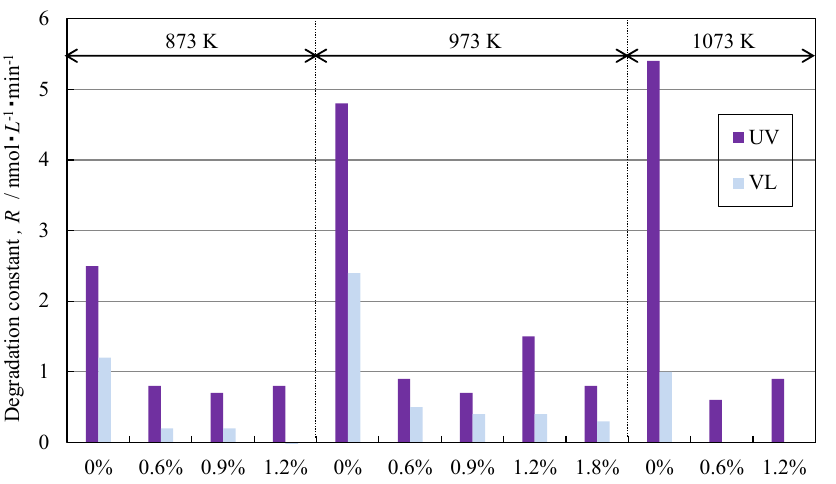
Figure 53. Degradation rate constant and X R of M10- x Cr- y K